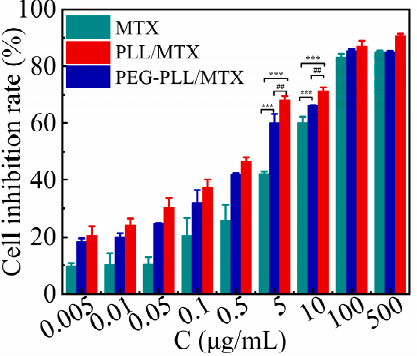
Figure 6. Inhibitory effect of MTX and the two NPs after 48 h incubation against 4T1 cells at 37 °C (n = 5). *** p < 0.001 vs. MTX injection; ## p < 0.01 vs. PEG-PLL/MTX NPs.